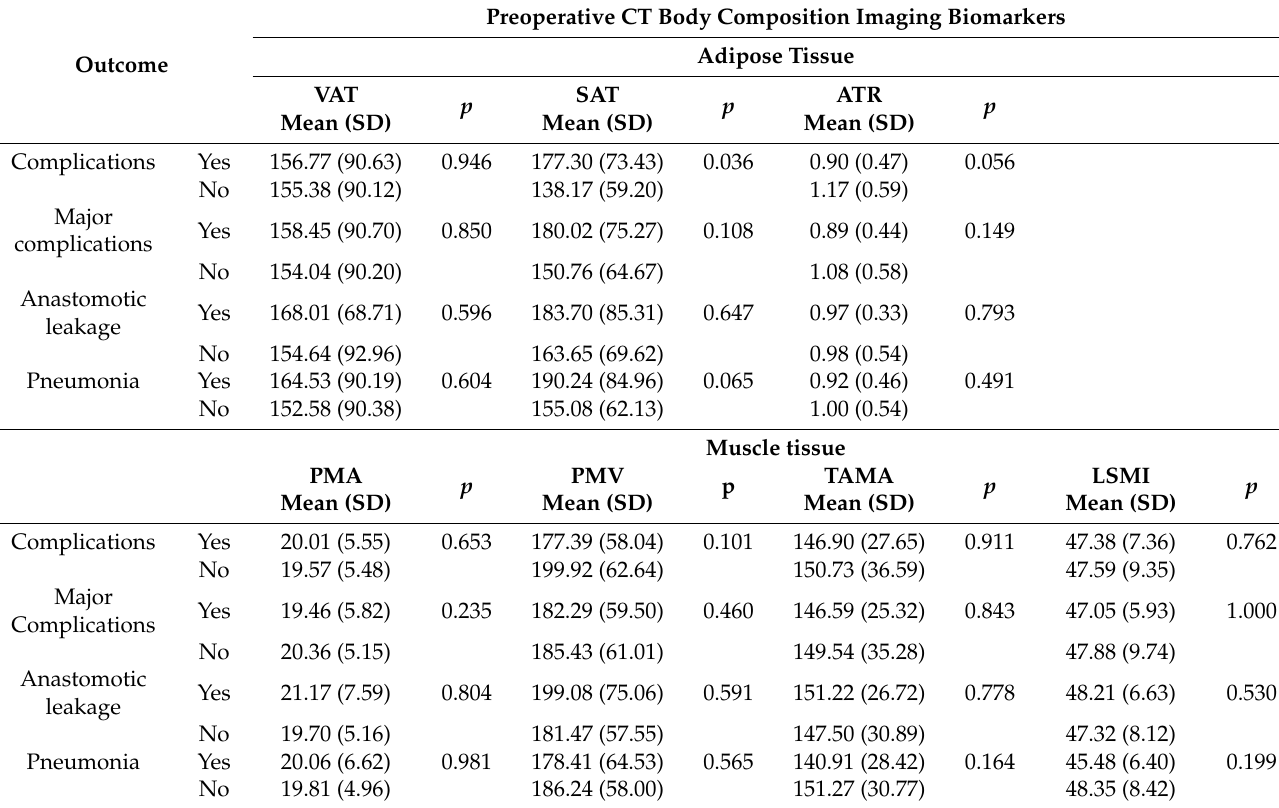
Table 2. Correlation analysis of preoperative CT body composition imaging biomarkers to postoperative complications. Preoperative CT Body Composition Imaging Biomarkers Outcome